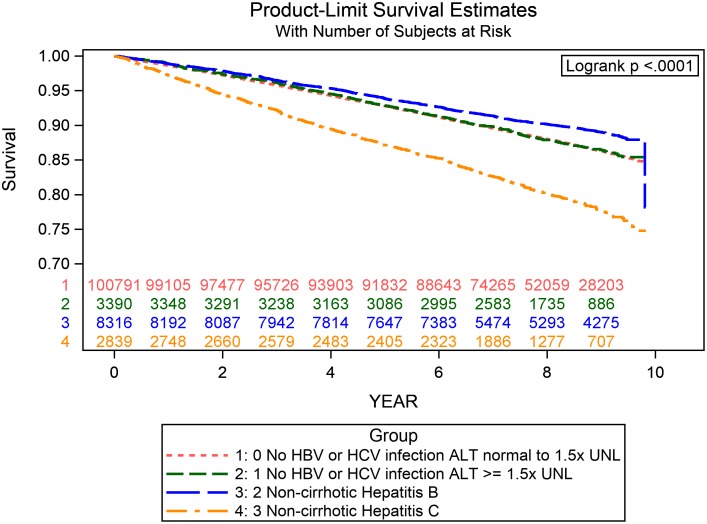
The Kaplan-Myer curves for the incidence of any hospitalization due to infection in different liver disease categories.The red line (“no HBV or HCV infection ALP normal to 1.5xUNL”) represents NBNC participants with normal to mildly elevated liver enzyme; the green line (“no HBV or HCV infection ALP ≥ 1.5x UNL”) represents NBNC participants with moderate to markedly elevated liver enzyme; the blue line (“non-cirrhotic Hepatitis B”) represents patients with NC-HBV; and the orange line (“non-cirrhotic Hepatitis C”) represents patients with NC-HCV. ALT, alanine aminotransferase; HBV, hepatitis B virus; HCV, hepatitis C virus; UNL, upper normal limit.